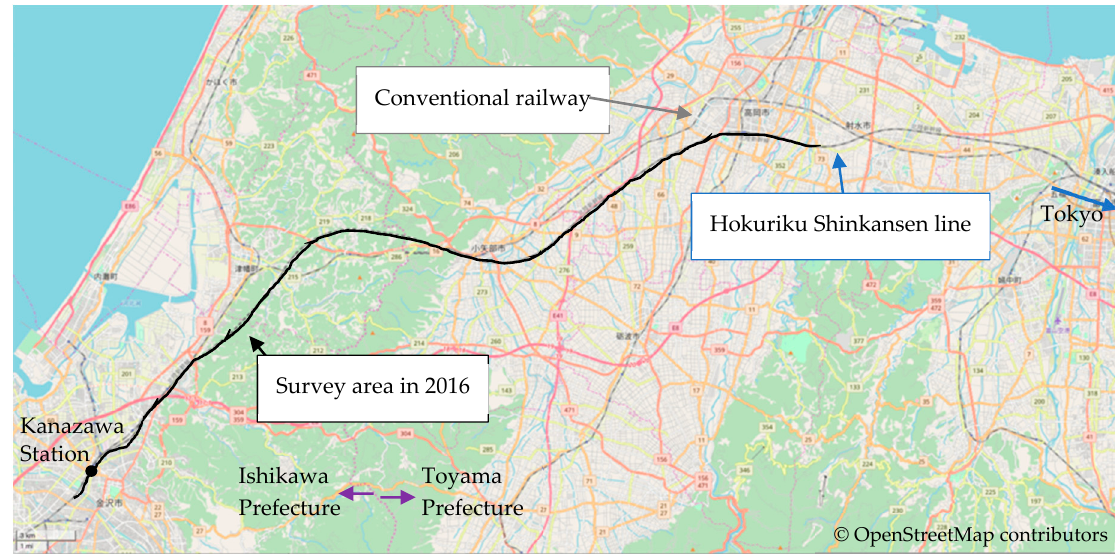
Figure 1. Route of Hokuriku Shinkansen and area of social survey.